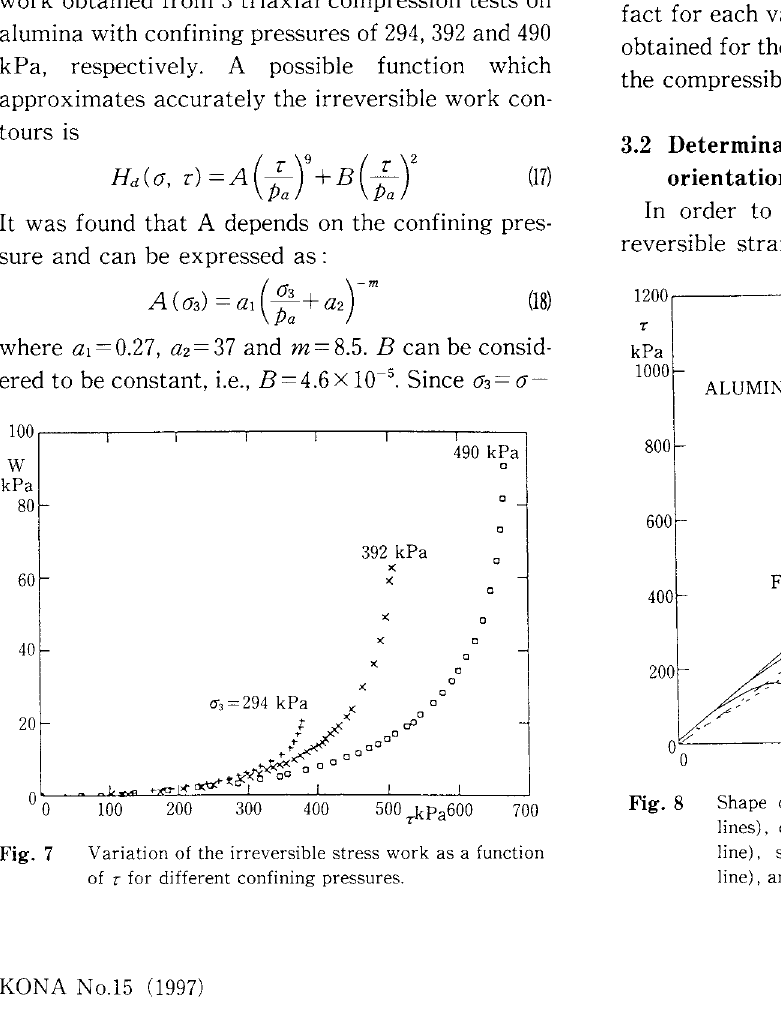
Shape of several yield surfaces H =constant (solid 700 lines). compressibility /dilatancy boundary (dash-dot line), stability boundary surface iiH/ ila= 0 (dotted line), and short-term failure surface (solid